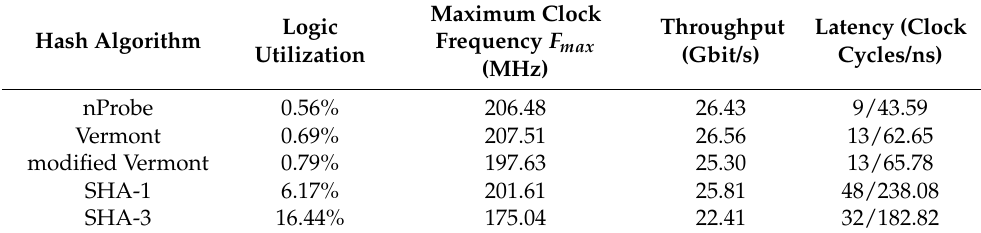
Table 5. Module netprobe_top implementation results in Stratix V